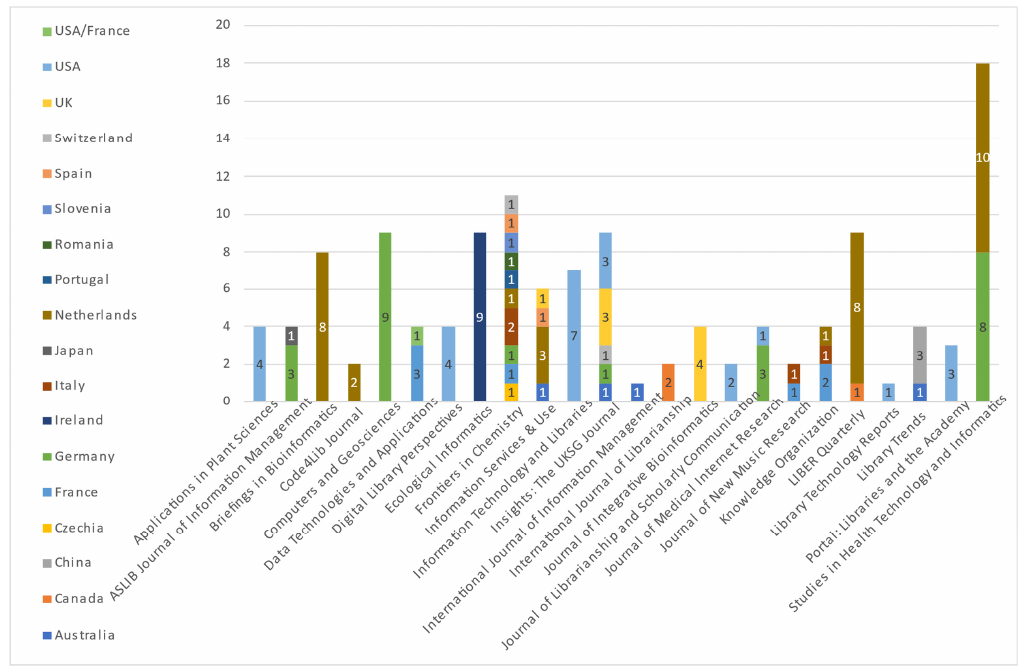
Figure A2. Geographical distribution of authors by journal.